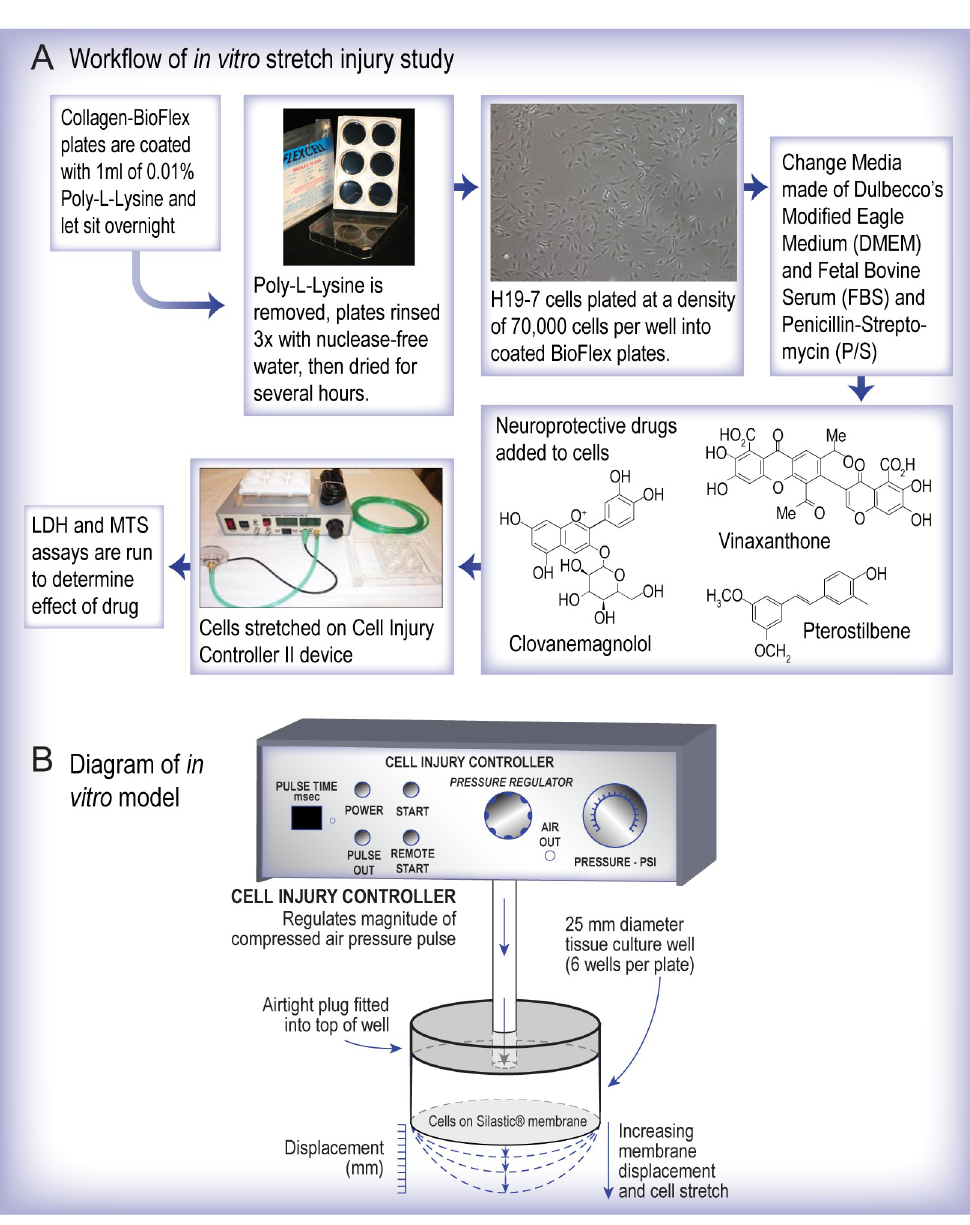
Fig 1. Research design and in vitro model. (A) Workflow of the in vitro stretch injury study. (B) Diagram illustrating the mechanism by which the 50 msec, 50 psi stretch injury is delivered onto the cells. The airtight plug is fitted into the well and delivers the burst of nitrogen gas. Figure adapted from Cohen et al. Prog Brain Res.